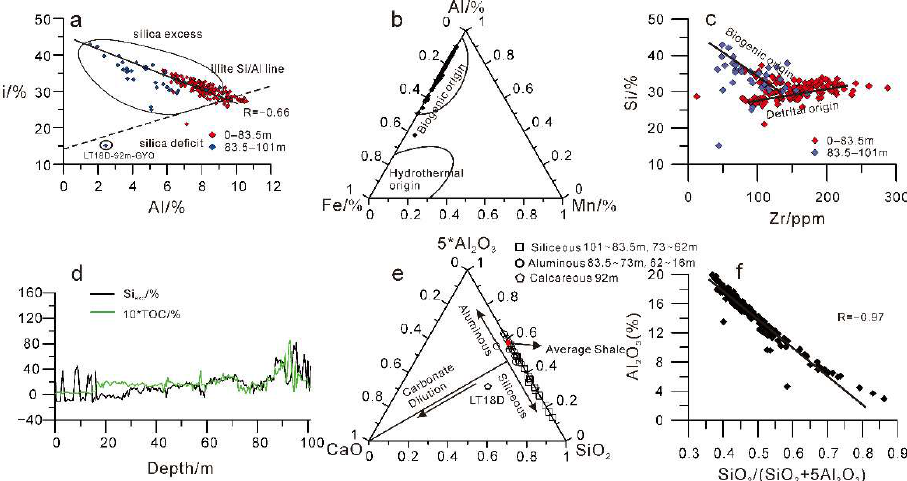
Figure 5. The geochemical diagrams. In Figure 5a,e, sample LT-18D (sampled from GYQ layer at depth of 92 m) was plotted at an area far from other samples because this sample is calcareous shale and diluted by the carbonate. (a) the scatter plot between Al and Si; (b) the Al-Fe-Mn ternary diagram; (c) the scatter plot between Zr and Si; (d) the Si exc and 10*TOC profiles; (e) the 5*Al 2 O 3 -CaO-SiO 2 ternary diagram; (f) the scatter plot between SiO 2 /(SiO 2 +5Al 2 O 3 ) and Al 2 O 3 . Element Zr is typically associated with heavy mineral zircon and can be used as terrigenous proxy. Thus, a Si (%)-Zr (ppm) cross-plot can be used to determine whether the Si in the strata is contributed to by terrigenous or biogenic inputs. A positive correlation between Zr and Si indicates the terrigenous contribution of SiO 2 , while a negative between them implies biogenic contribution. As shown in Figure 5c, the Si (%)-Zr (ppm) cross-plot shows that the silica within Wufeng Fm. and bottom of the Lower Longmaxi Fm. belong